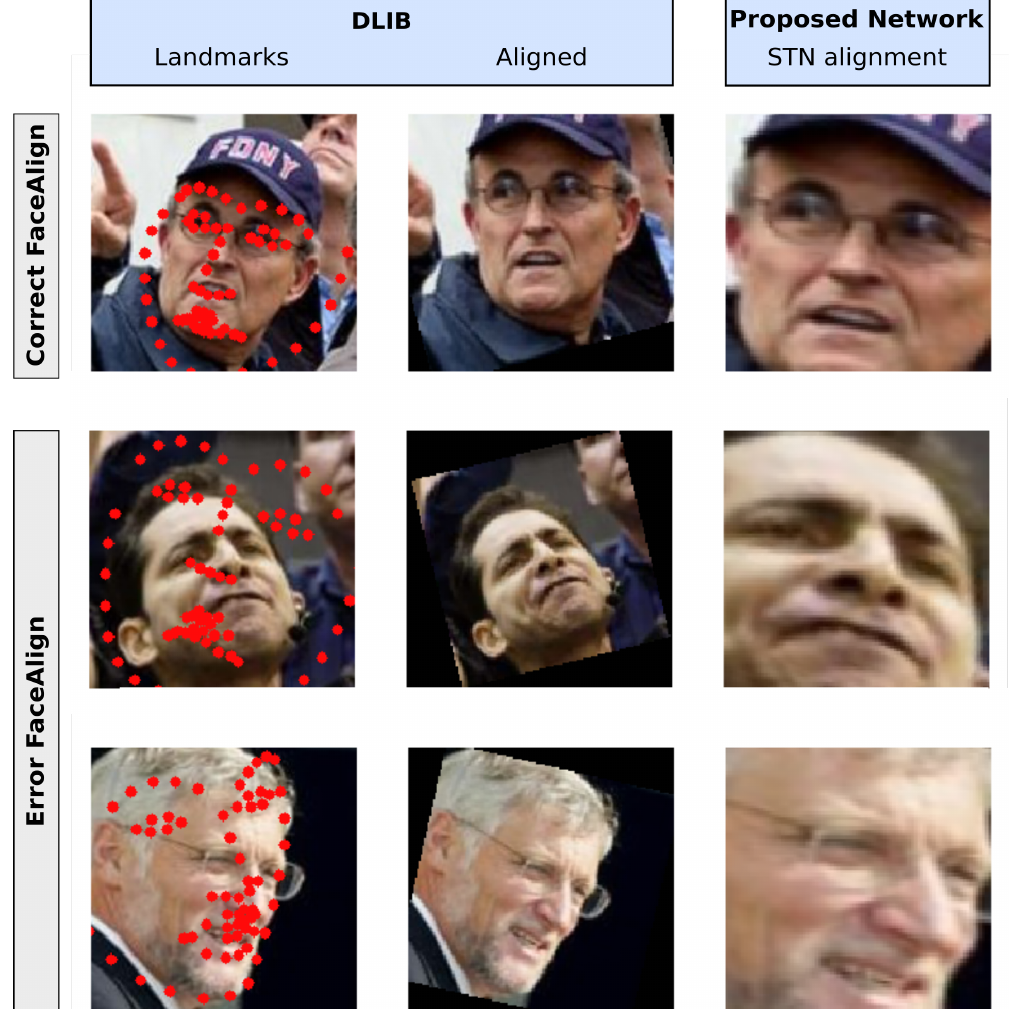
Figure 15. In this figure different alignments are compared for difficult face poses. In the first column, the landmark found with the dlib shape predictor are shown; in all the samples the error is heavily present. Only the face alignment procedure carried out on the first sample generates a correct recognition (a descriptor in the Euclidean space close to the centroid of its identity). The ‘distilled stn+net’ model is capable of correctly localizing and aligning the face, just like in any other